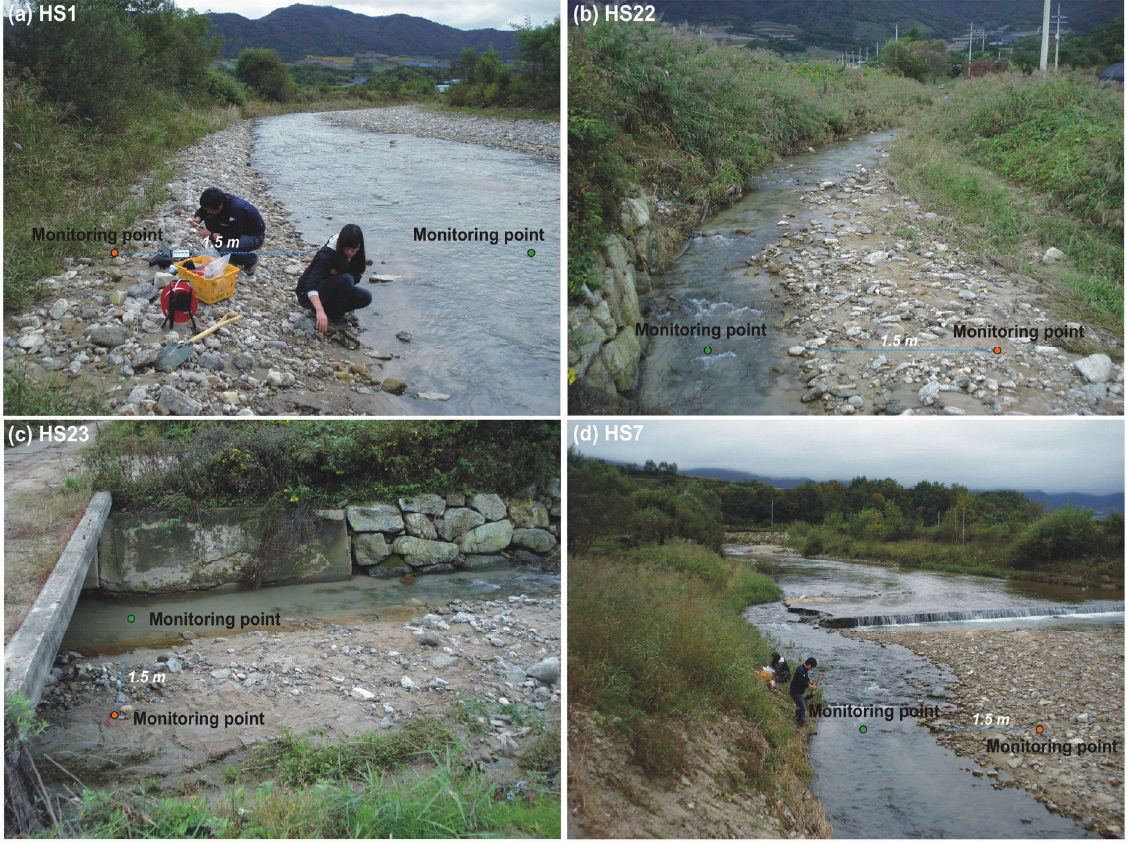
Figure 2. Photos showing the monitoring points for stream water, streambed (depth = 10 cm), and adjoining sediment (depth = 10 cm). ( a ) HS1; ( b ) HS22; ( c ) HS23 and ( d )